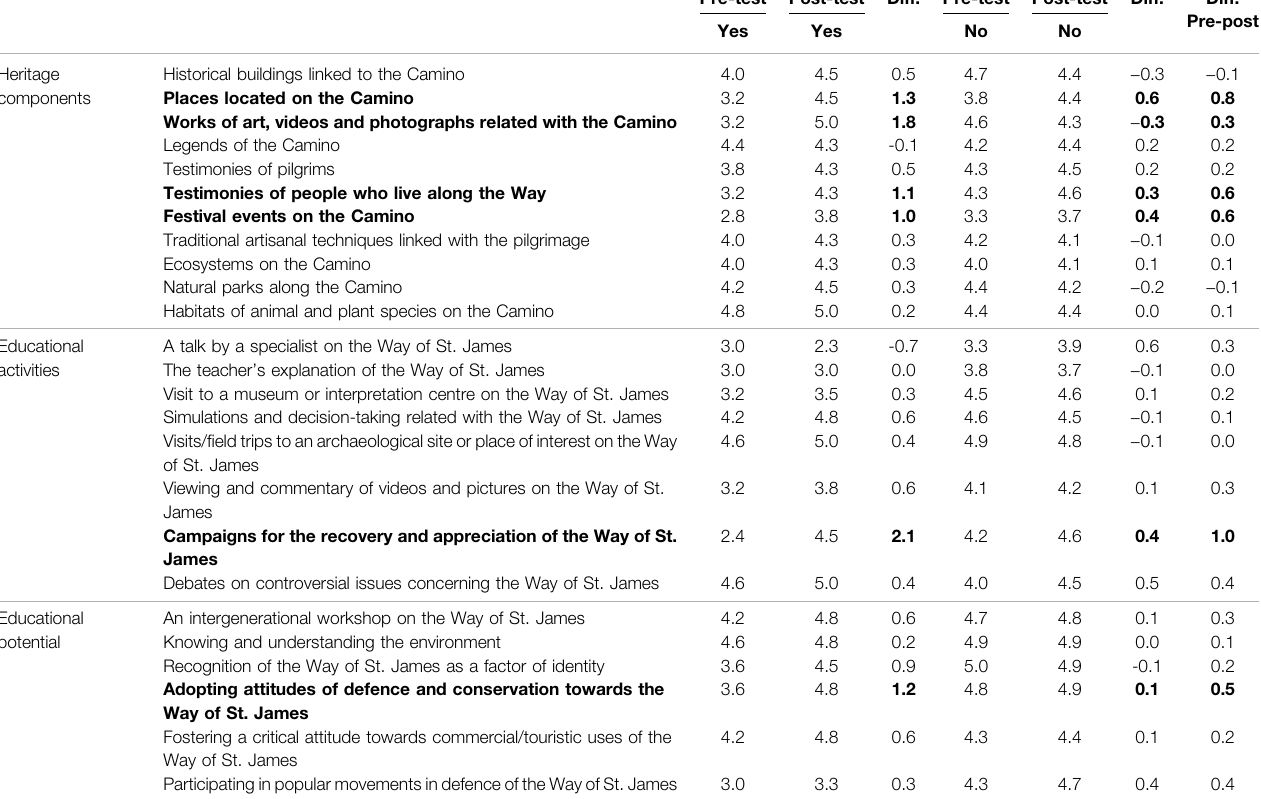
Pre-test Post-test Diff.